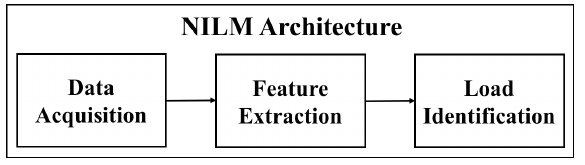
Figure 12. Non-intrusive load monitoring (NILM) architecture (adapted from